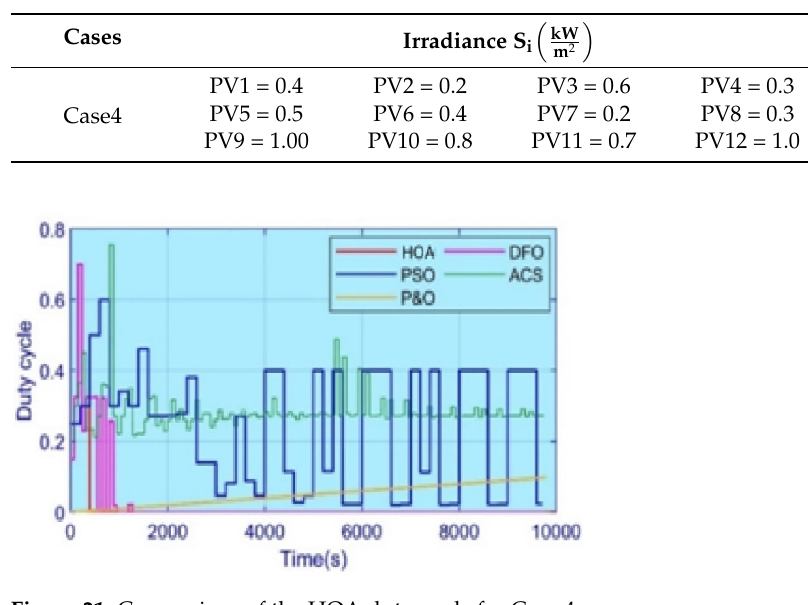
Figure 21. Comparison of the HOA duty-cycle for Case 4 .